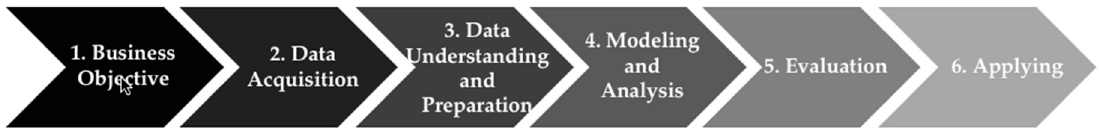
Figure 1. Propose big-data analytics process for service innovation development. Source: Compiled by authors according to documentary research.